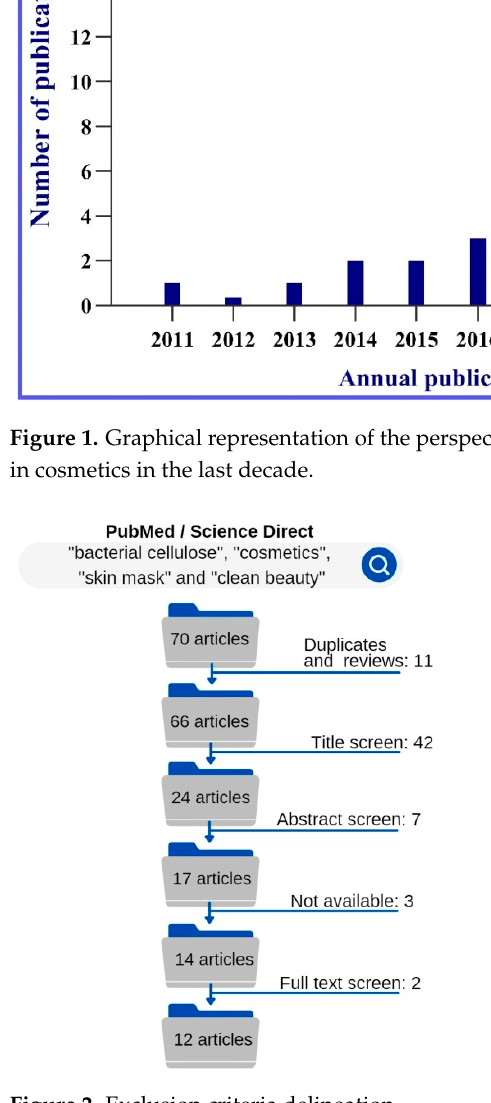
Figure 2. Exclusion criteria delineation.